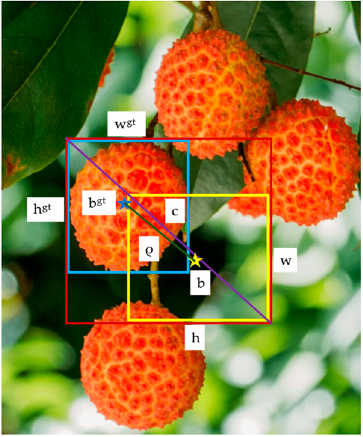
Figure 6. A diagram of the CIoU loss function. In the diagram, the blue rectangle represents the ground truth box, the yellow rectangle represents the prediction box, and the red rectangle is their smallest circumscribed rectangle. w gt is the width and h gt is the height of the ground truth box, and w is the width and h is the height of the prediction box. b gt is the center position of the ground truth box, and b is the center position of the prediction box. ρ is the distance between the two center positions measured by Euclidean distance, and c represents the distance between the prediction box and the smallest circumscribed rectangle. The CIoU loss function is primarily composed of three